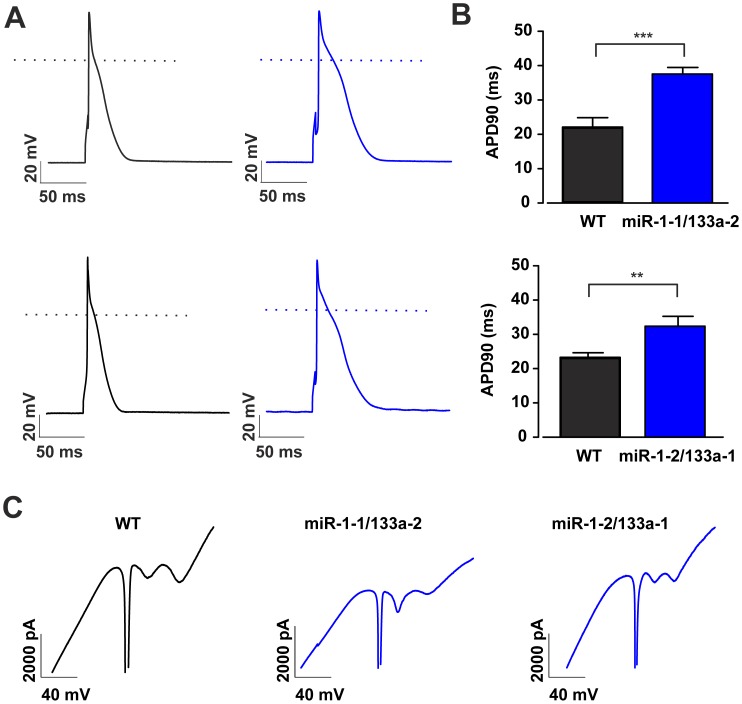
Increased Action Potential Duration at 90% of repolarization (APD90) in miR-1/133a knock-out ventricular cardiomyocytes.Action potential (AP) traces in isolated adult ventricular cardiomyocytes from the respective miR-1/133a cluster knock-out animals (blue) and the corresponding controls (black). APs were elicited by 2.5 ms lasting current injections of 800–1000 pA through the patch pipette (A). Statistical analysis of APD90 in miRNA control (WT) and respective miR-1/133a knock-out cells (B). Representative ramp depolarizations (−150 mV to +60 mV, 250 ms; holding potential −80 mV) recorded from WT and miR-1/133a KO ventricular cardiomyocytes (C) prove the functional expression of the most important ion currents.